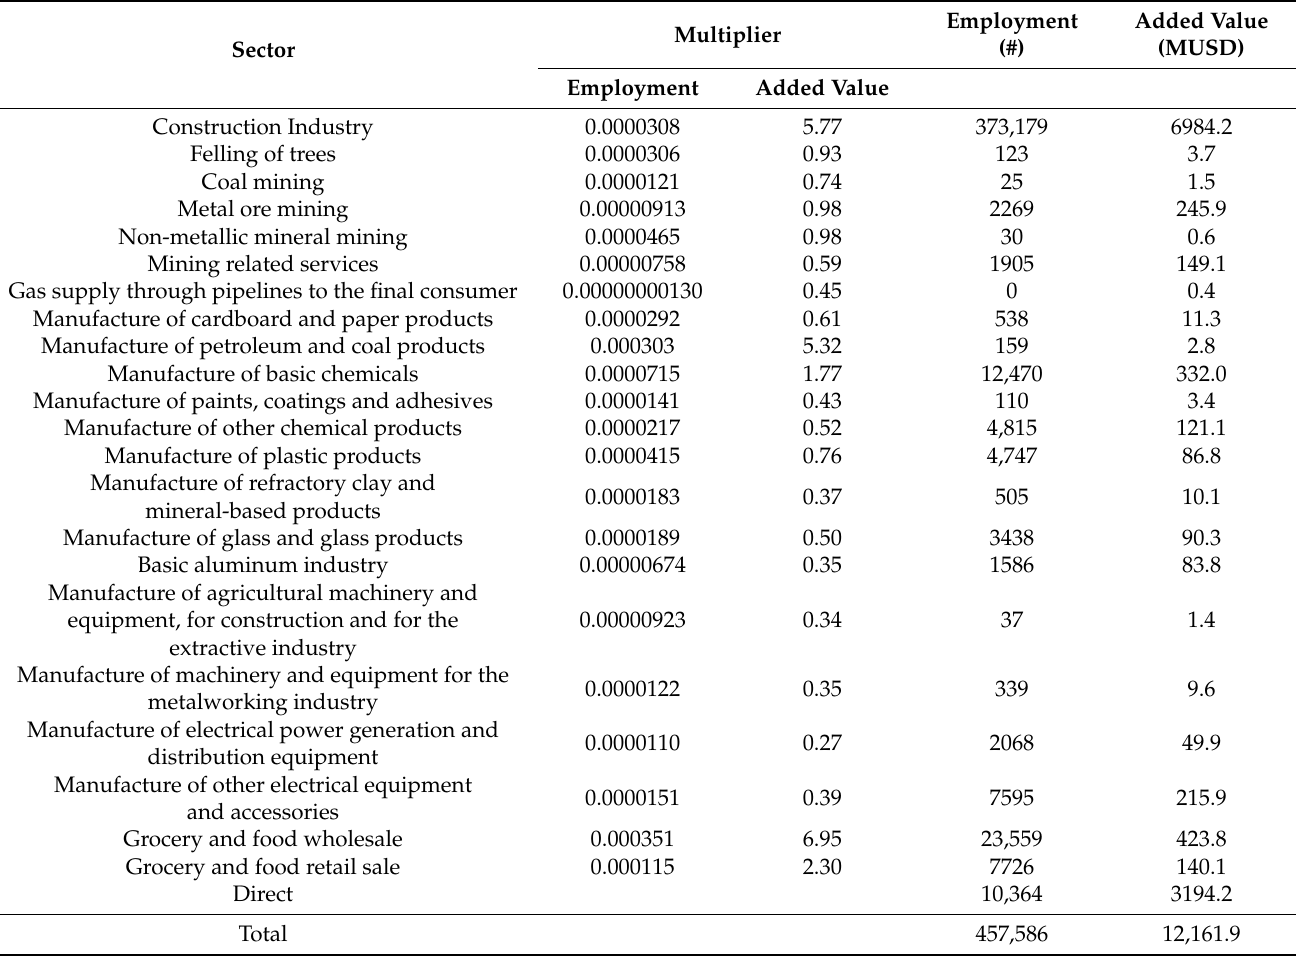
Table 14. Total socioeconomic benefits of the development and integration of the VCPVIM in the Alternative Scenario by 2040.